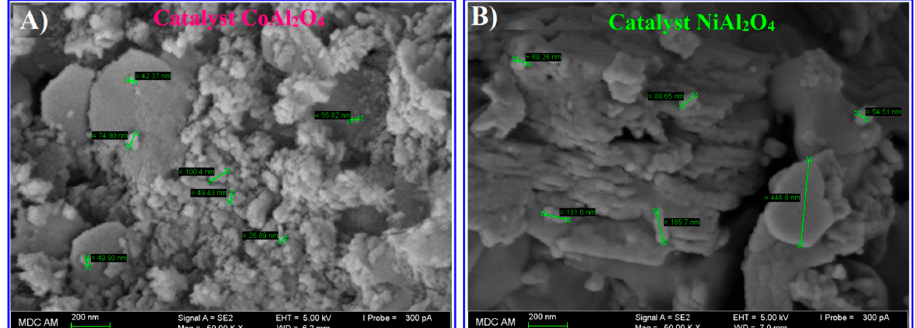
Figure 8. Morphological structure of Co/Al 2 O 4 ( A ) and Ni/Al 2 O 4 ( B ) catalysts obtained from SEM.